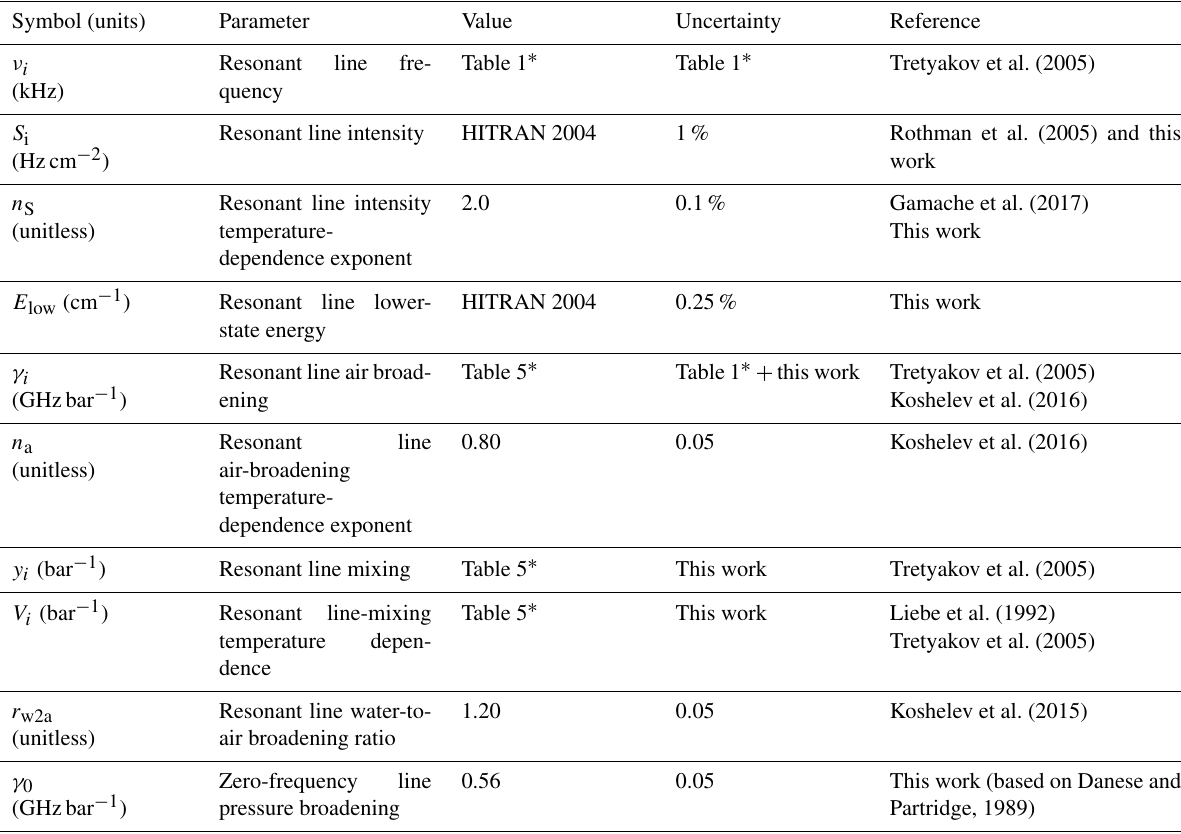
Table 2. List of oxygen parameters perturbed in the sensitivity analysis. ∗ Tables 1 and 5 from Tretyakov et al. (2005).